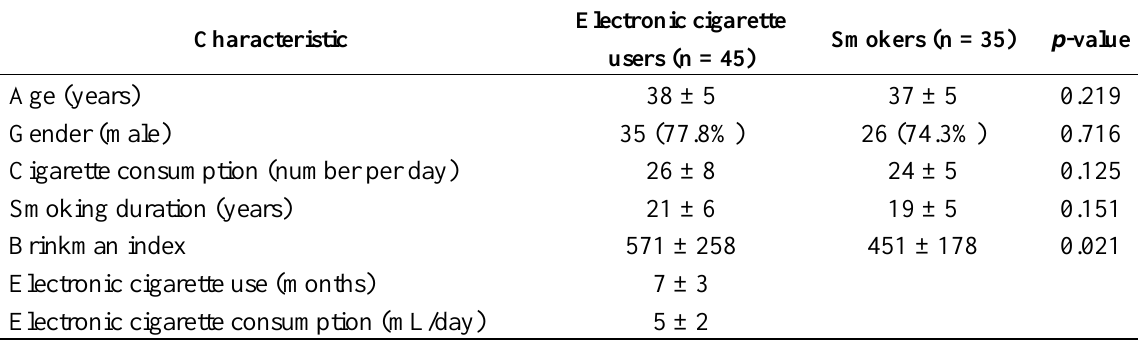
Table 1. Baseline characteristics of the study